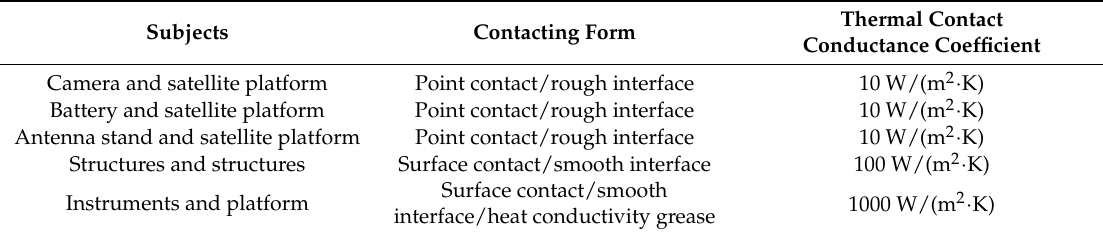
Table 4. Thermal contact conductance coefficient between elements.